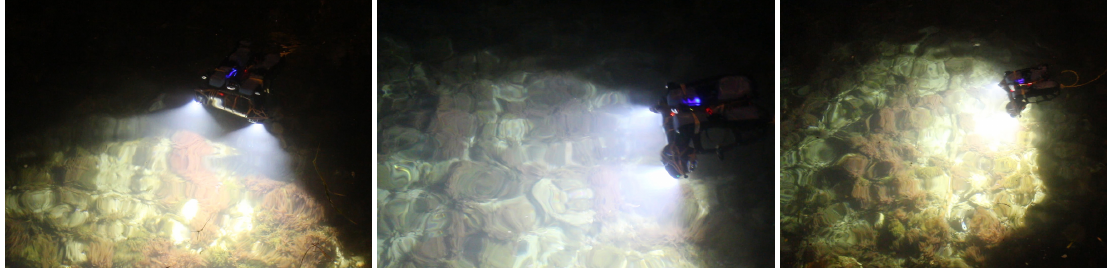
Figure 4. The built trifocal Remotely Operated underwater Vehicle (ROV)-attached system in action.